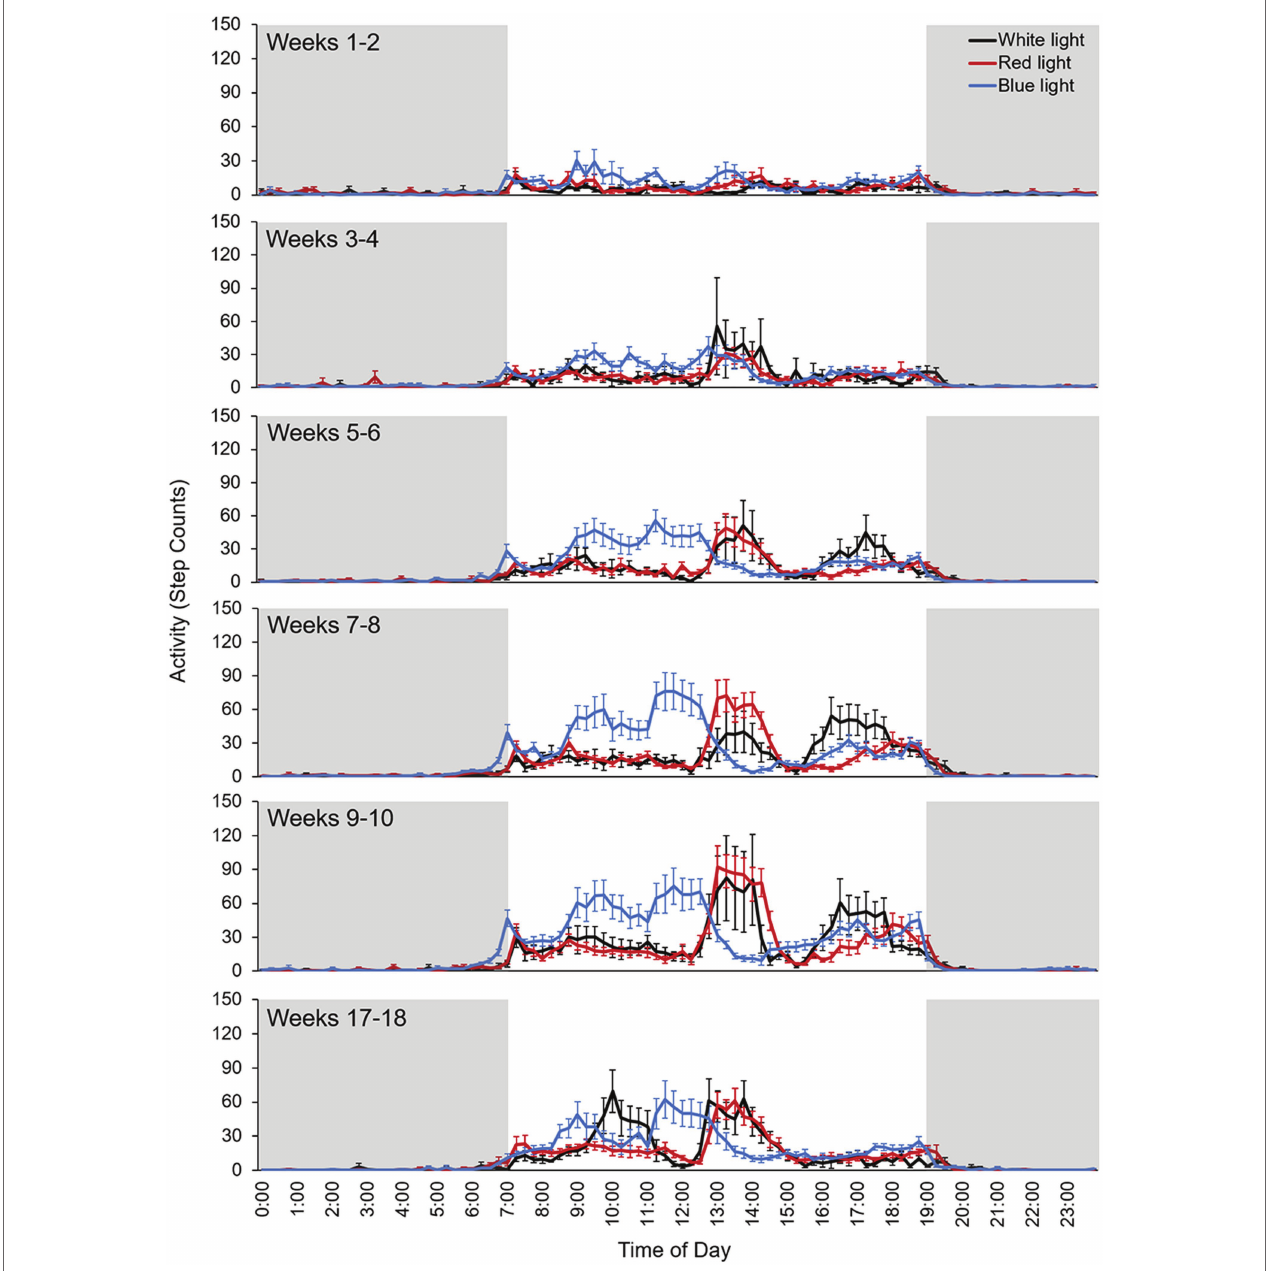
FIGURE 2 | Averaged daily activity cycles for each 2-week bin for monkeys reared in white light (black line), red light (red line), and blue light (blue line). Step counts were recorded at 15-min intervals. Error bars represent SEM. Shaded areas indicate the lights-off